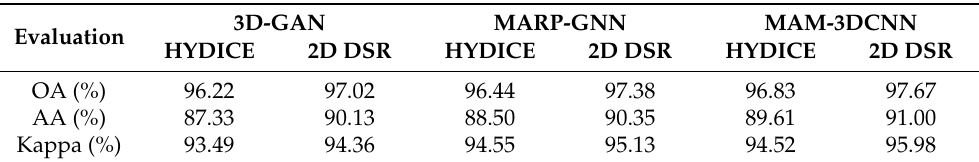
Table 6. Classification of the original and 2D-DSR-enhanced HYDICE by methods based on the GNN and